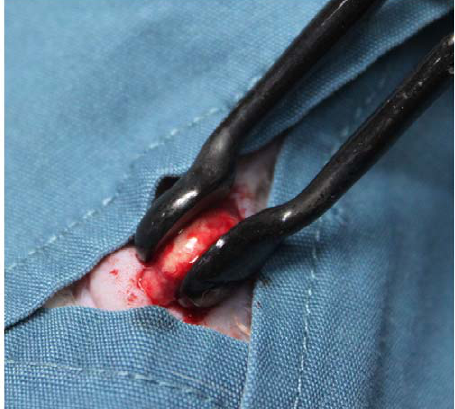
Figure 1. The IRE device clamping the tumor in the rat.